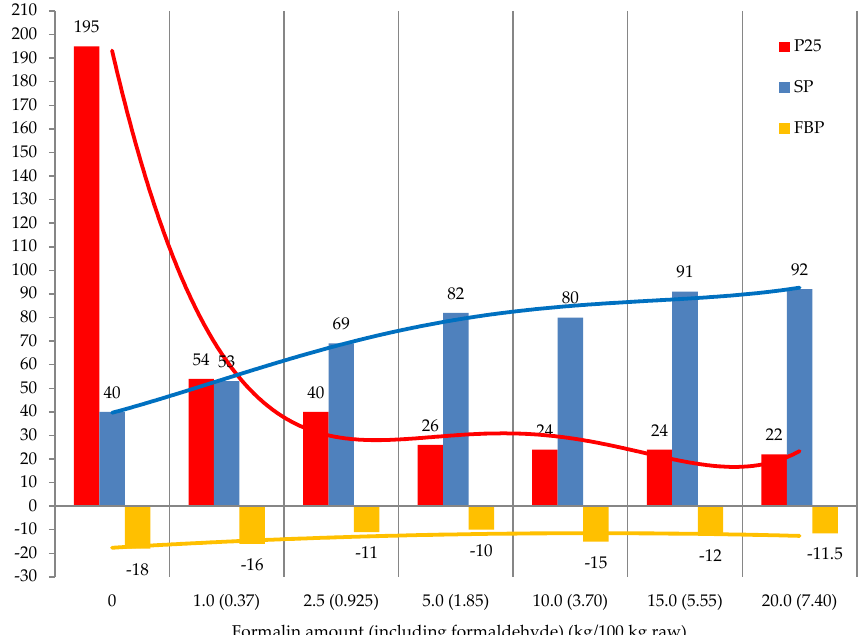
Figure 10. The effect of formalin amount on the modification process: raw is Т1; catalyst amount (H 2 SO 4 ) is 2.5 kg/100 kg raw; temperature 100 °C; duration 0.5 h .